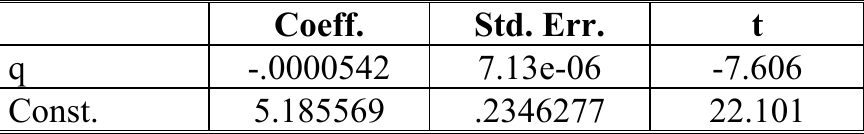
Results of estimating a constrained semilog demand function for tourists from African countries Coeff. Std. Err.